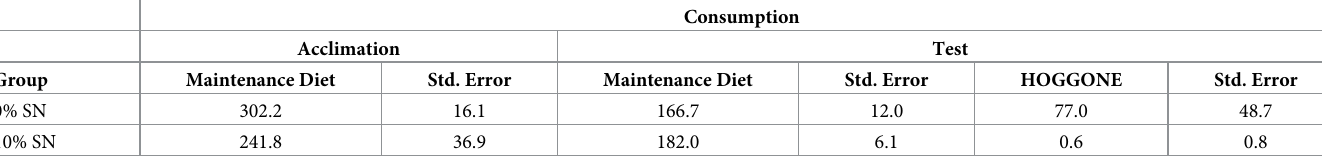
Table 4. Consumption (g) of the maintenance diet and the HOGGONE bait (0% and 10% sodium nitrite) among European starlings during the acclimation and test phases of Experiment 4.